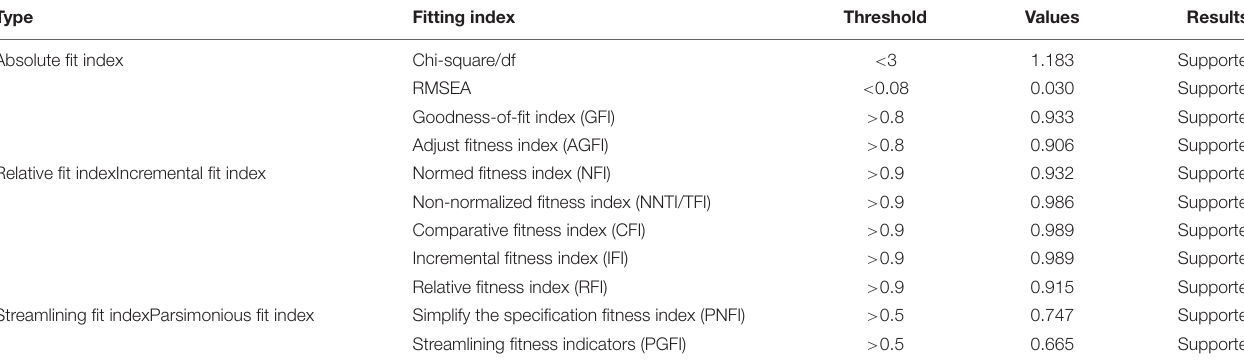
TABLE 4 | Framework fitting